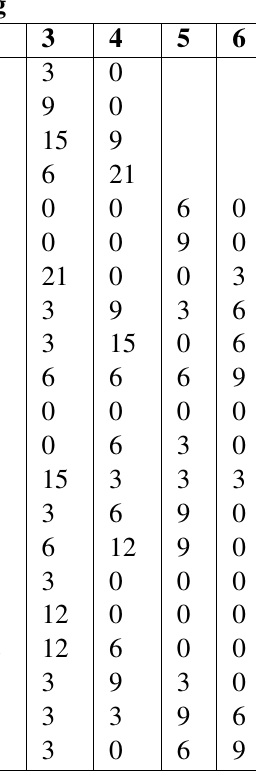
Table 3 Expert statistical survey results on the importance of the subordinate indicators of each category Class